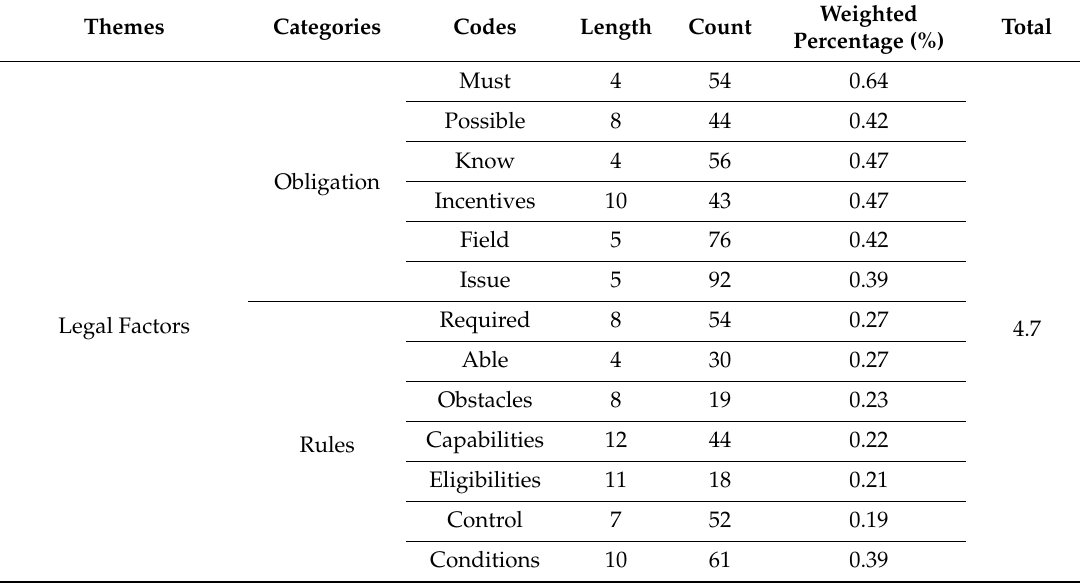
Table 6. Word frequencies for legal factors theme.